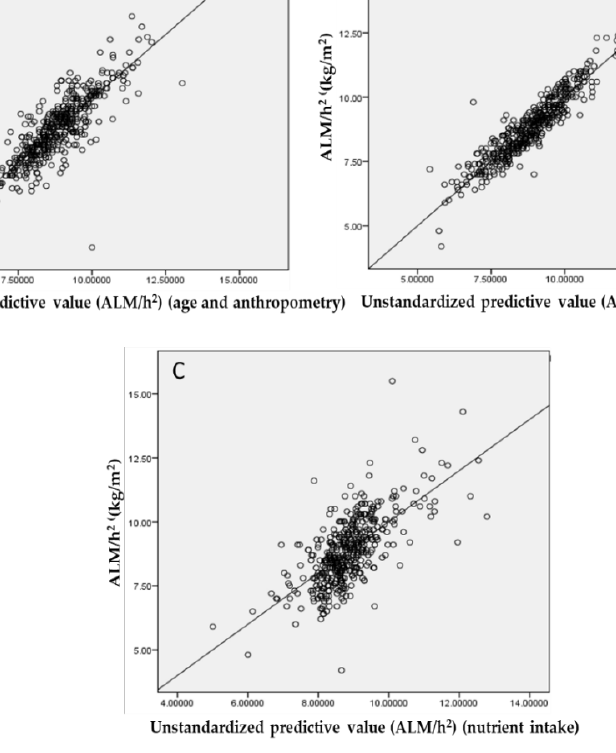
Figure 2. Multiple regression analyses between ALM/h 2 and age and anthropometry (( A ) R 2 = 0.869), body composition (( B ) R 2 = 0.713), and nutrient intake (( C ) R 2 = 0.450). ( n = 441). Abbreviations: ALM, appendicular lean mass.